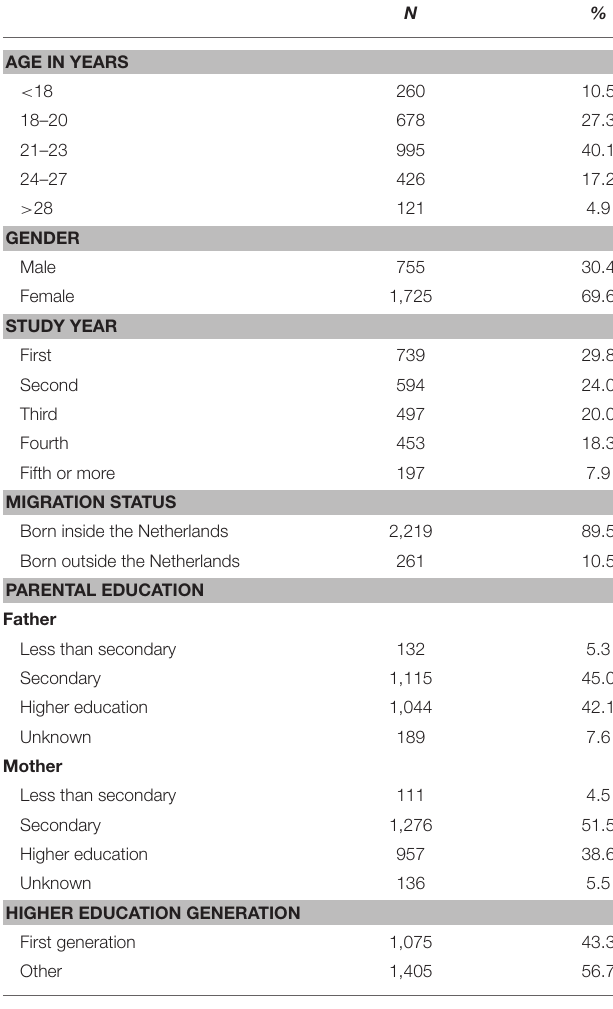
TABLE 1 | Sociodemographic characteristics of participants ( N =